Question: Which visualization type does this figure use?
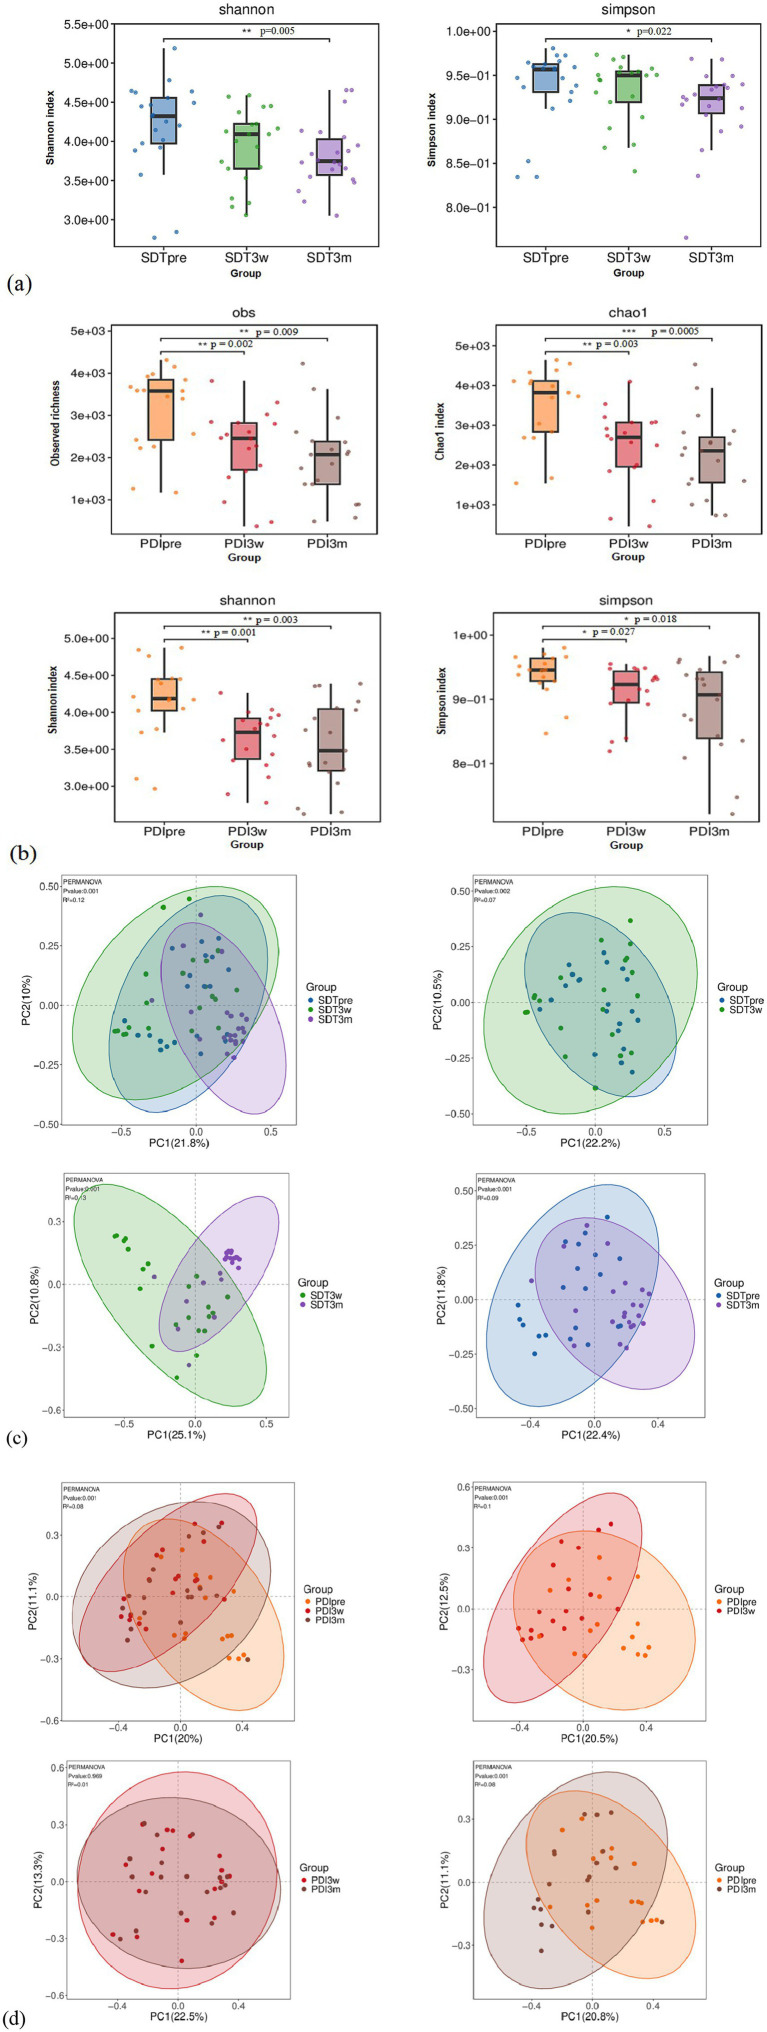
Answer: box